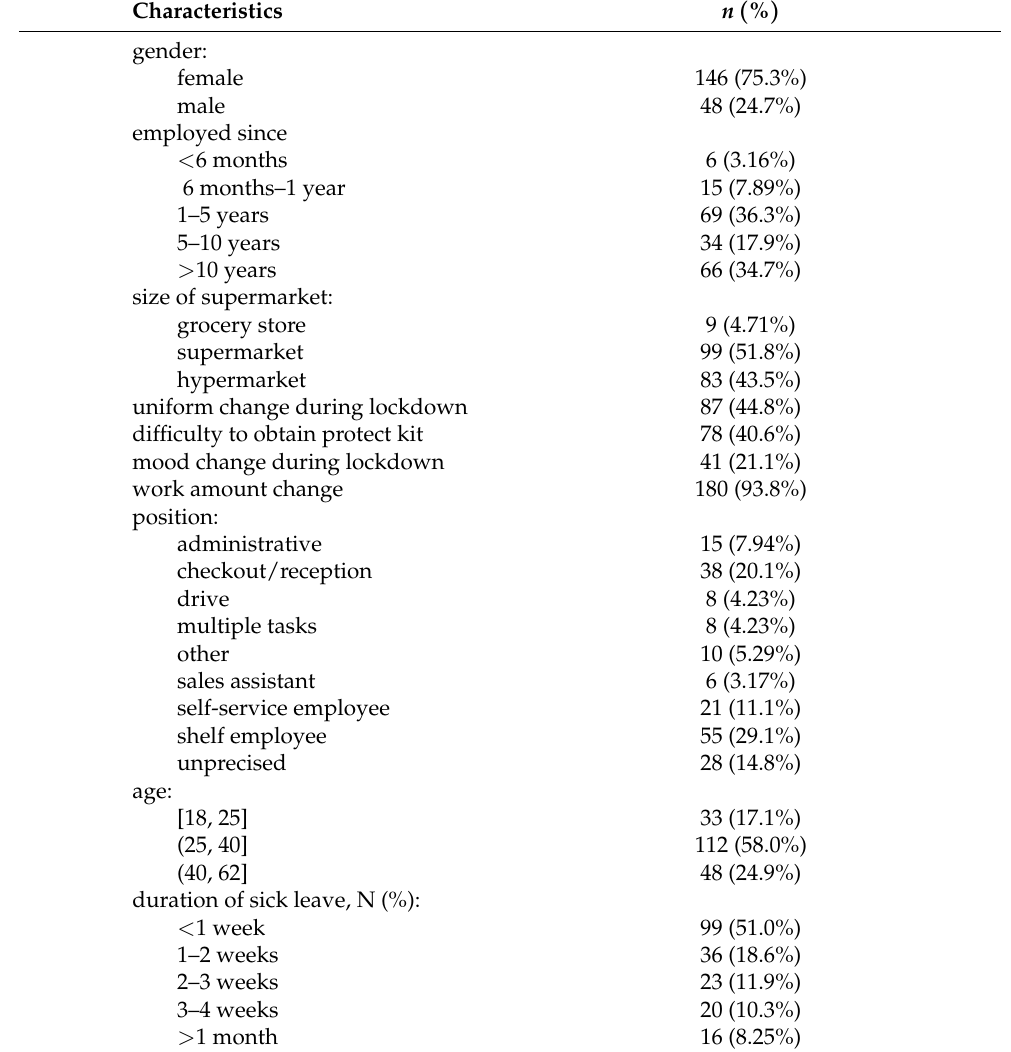
Table 2. Descriptive statistics: employees working and sick during quarantine ( n = 194).